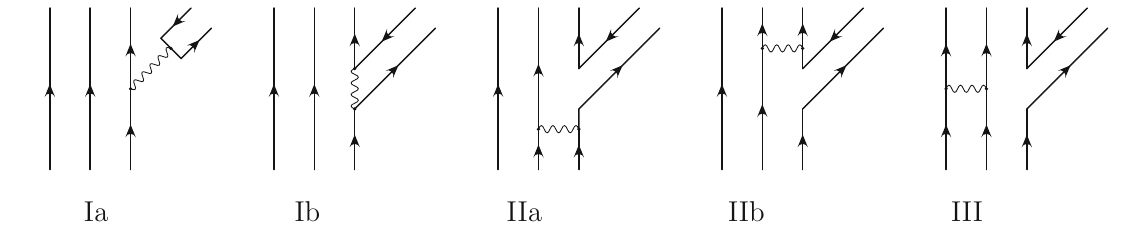
Fig. 1 The topological diagrams contributing to the nonleptonic charm baryon decays